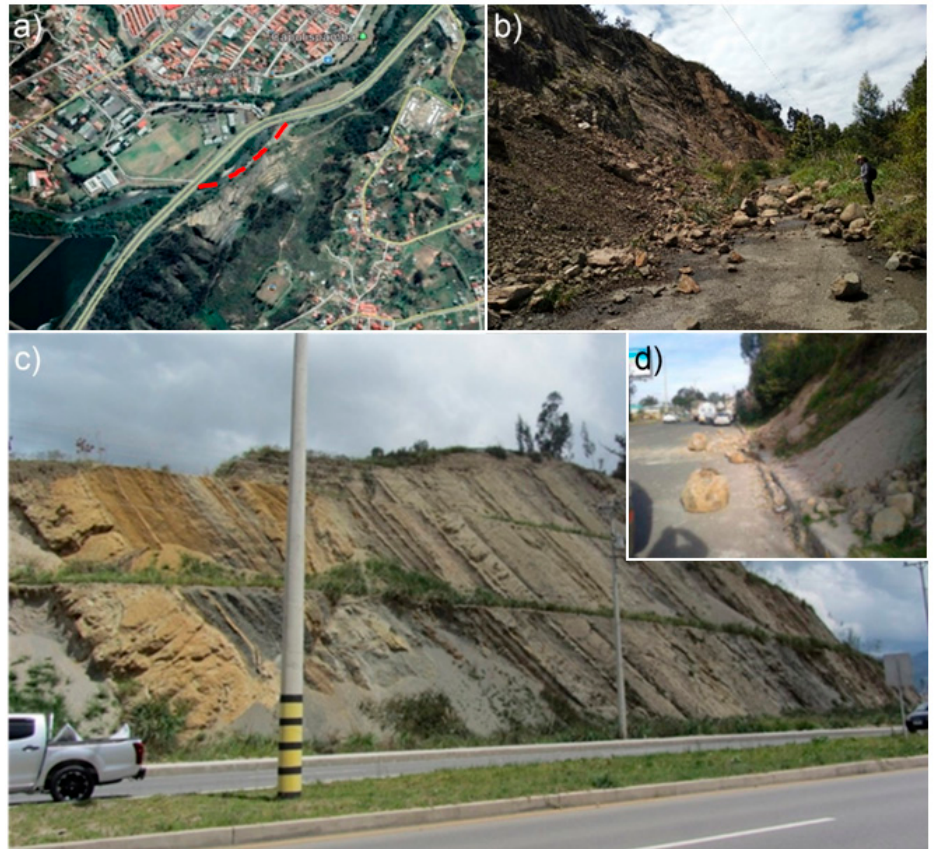
Figure 2. The functionality of the Pan-American Highway is often interrupted by rockfalls. ( a ) De- viation of the original road axis (red dotted line) caused by rockfall events; ( b ) landslide deposits have almost completely invaded the highway; ( c ) overdip cataclinal slope: the stratification is slope-oriented; ( d ) boulders detached from the slopes block the lane.